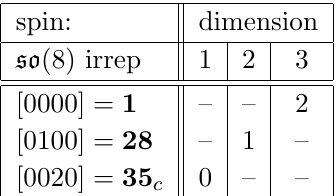
Table 3 . All possible conformal primaries in O Stress (cid:2) O Stress corresponding to the stress-tensor superconformal